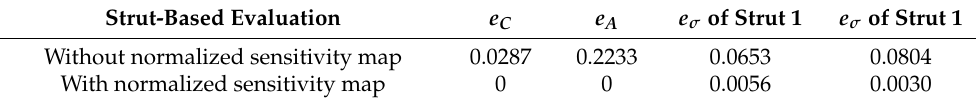
Figure 13. ( a ) The reconstructed conductivity values of each element when solved with the normal- ized sensitivity map are plotted. ( b ) The corresponding 3D conductivity distribution of the lattice structure successfully identified breaks in strut 1 and strut 2. Table 7. Errors quantification and comparison of multi-defect reconstructions in experiment.